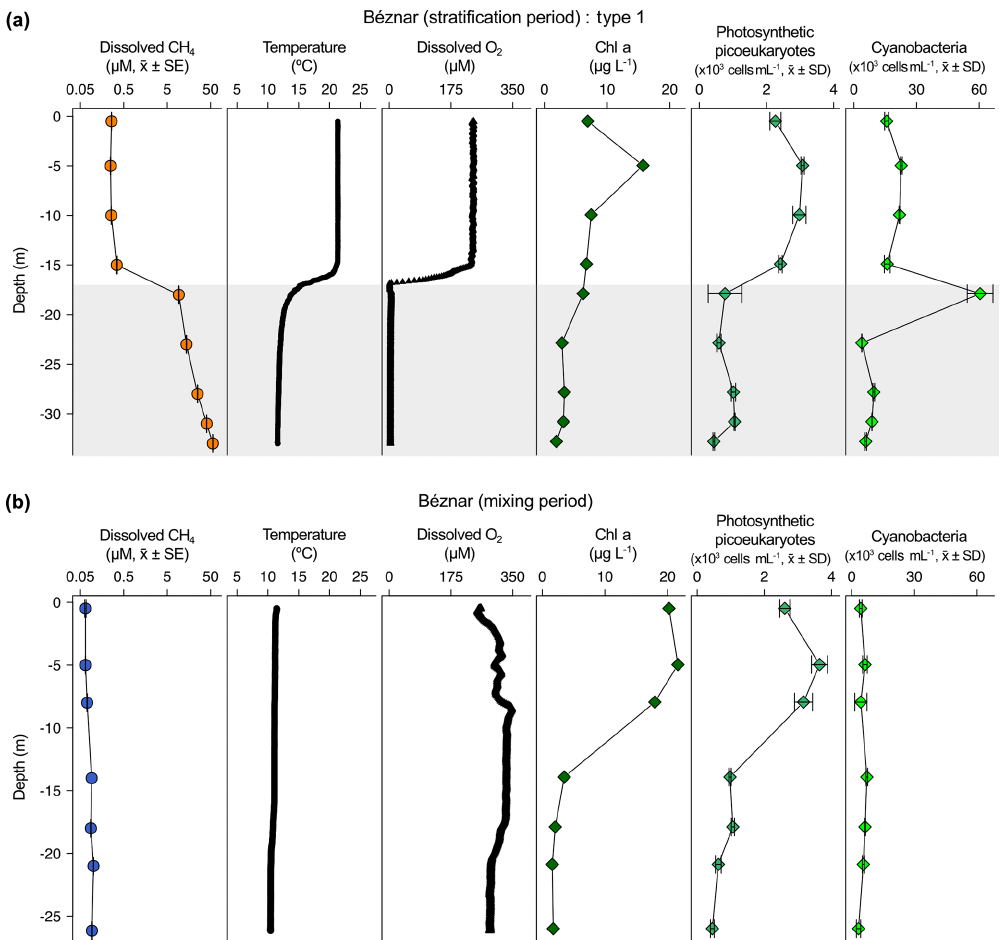
Figure 2. Vertical profiles of physicochemical and biological variables in Béznar reservoir. Dissolved methane concentration (CH 4 , µM, mean ± standard error), temperature ( ◦ C), dissolved oxygen (DO) concentration (µM), chlorophyll a (Chl a ) concentration (µg L − 1 ), abun- dance of photosynthetic picoeukaryotes ( × 10 3 cellsmL − 1 , mean ± standard deviation), and abundance of cyanobacteria ( × 10 3 cellsmL − 1 , mean ± standard deviation) during the stratification period (a) and the mixing period (b) . The grey area represents the anoxic zone (DO < 7 . 5µM). Note the logarithmic scales in the x axis of the dissolved CH 4 profiles. The sampling for the stratification period was on 7 October 2016 and 23 February 2017 for the mixing